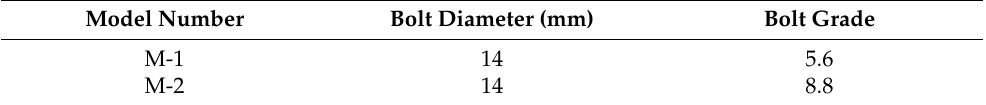
Table 6. Finite element model.